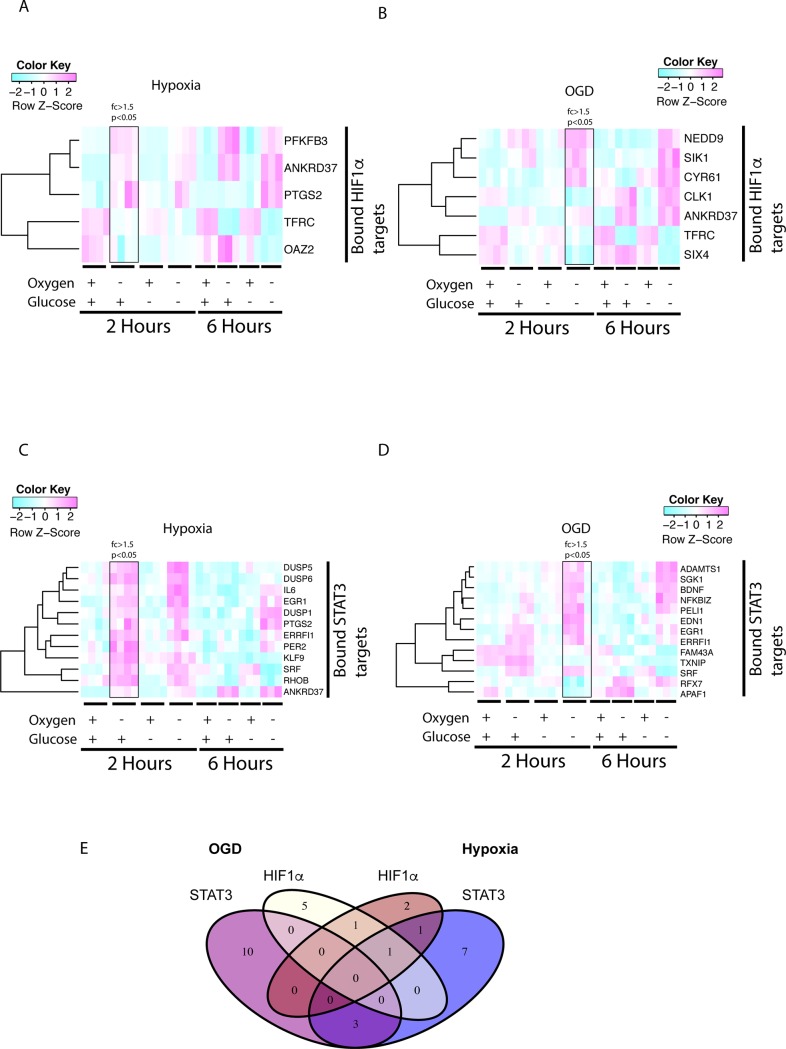
STAT3 drives both hypoxic and OGD responses stronger than HIF1α in 2h treated pericytes.Bound regulated genes (BRGs) with transcription factor occupancy within 5Kbp of a TSS for STAT3 and HIF1α were identified in by comparing ChIP-seq data to the pericytic Illumina gene expression data. (A) HIF1α alpha BRGs in the 2h hypoxic condition (fc>1.5, p<0.05) was plotted in a heat map. Panel (B) shows HIF1α BRGs in the OGD condition plotted in a heat map. (C) STAT3 BRGs after 2h of hypoxia and (D) 2h OGD. (E) A Venn diagram was constructed to highlight the differences in STAT3 or HIF1α BRG distribution between 2h hypoxic or OGD conditions.